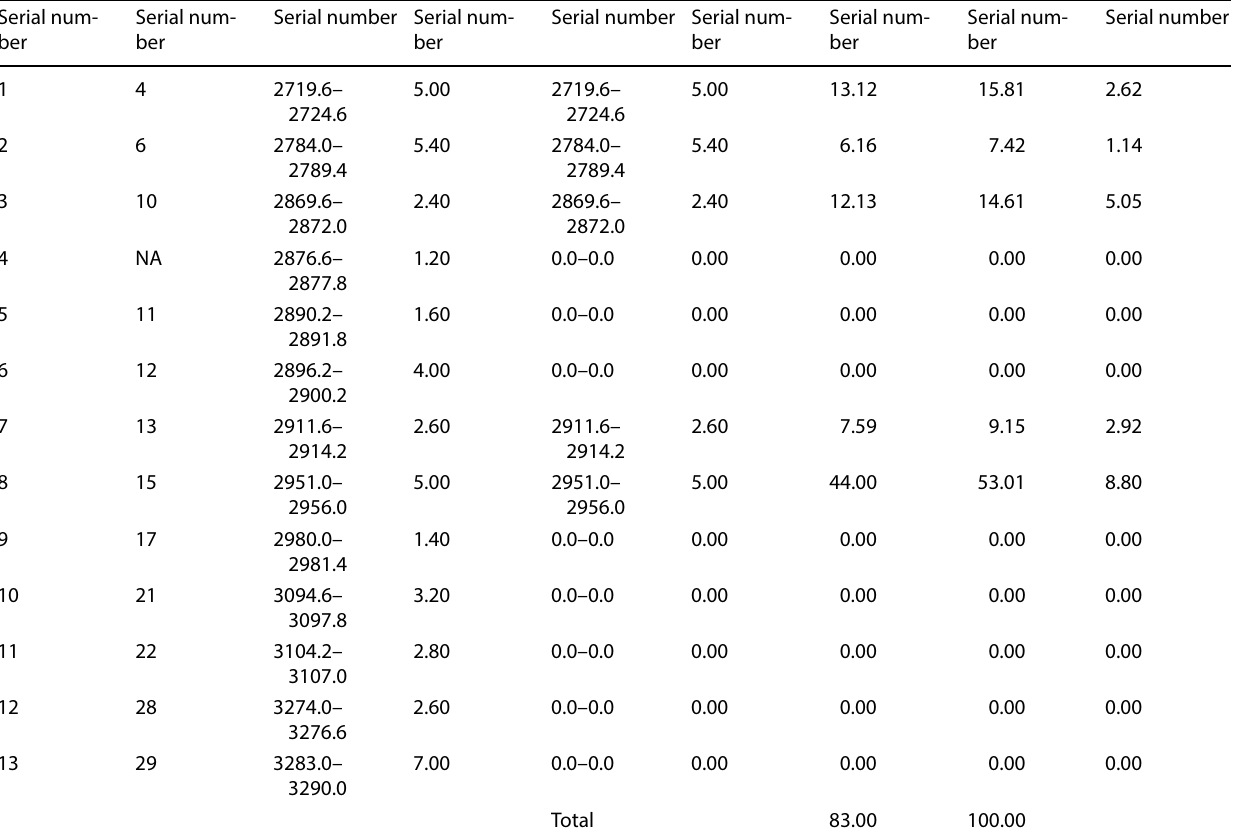
Table 1 Well X correlation flow injection profile logging results Serial num-